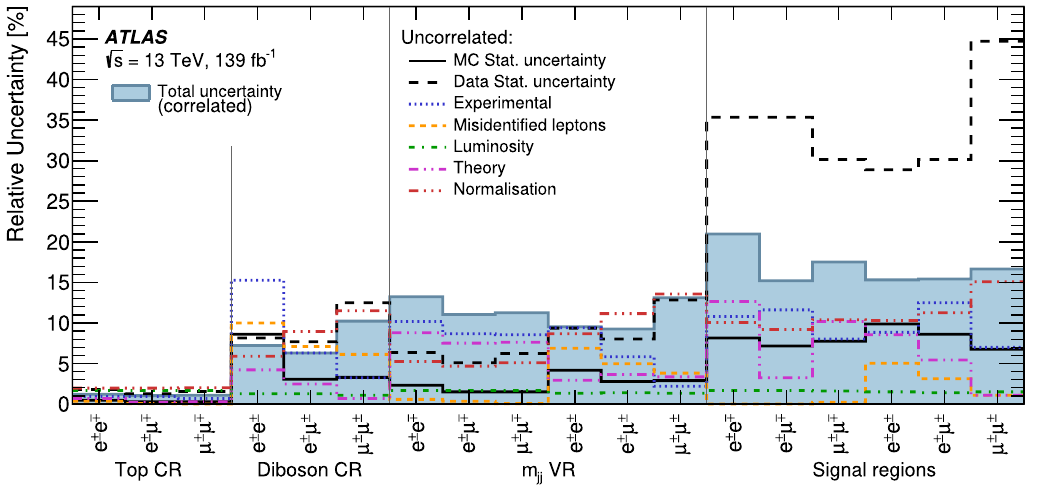
Fig. 6 Relative contributions of different sources of statistical and sys- tematic uncertainty in the total background yield estimation after the fit. Systematic uncertainties are calculated in an uncorrelated way by shifting in turn only one nuisance parameter from the post-fit value by one standard deviation, keeping all the other parameters at their post-fit